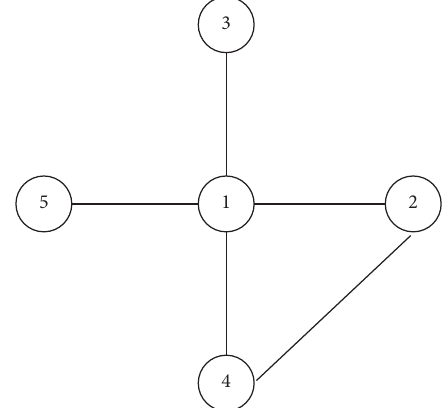
Figure 4: Schematic of degree centrality of node.